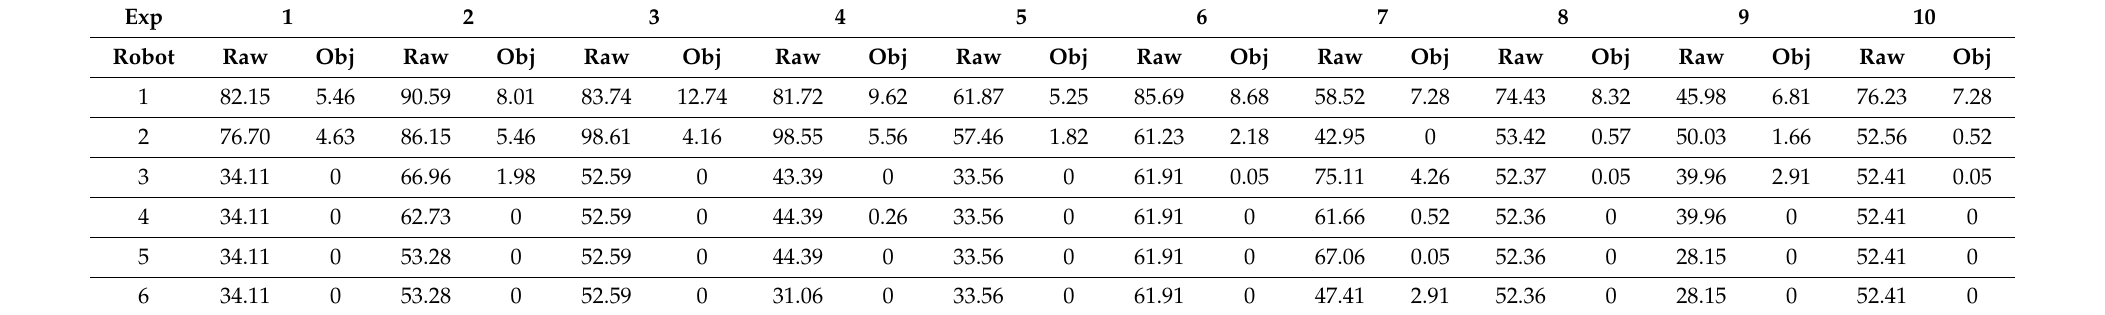
Table 2. Number of kB (kilobytes)